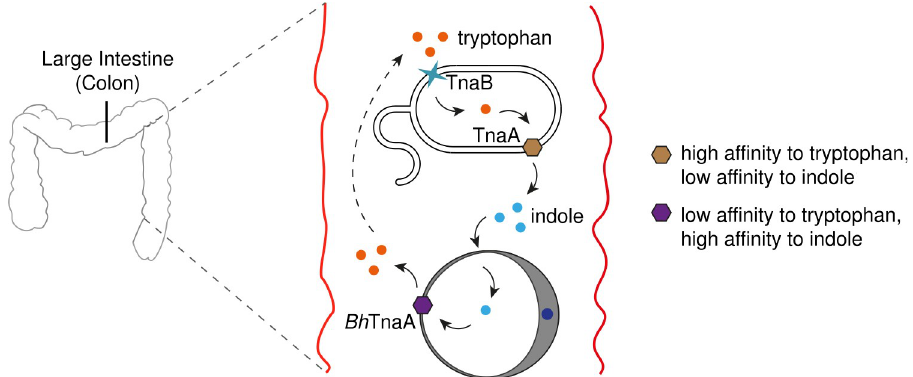
Fig 9. Tryptophan and Indole may exist cyclically in a Blastocystis -infected gut. Diagram of a hypothetical ‘tryptophan cycle’ between E . coli (upper) and Blastocystis spp . (lower) within the descending colon. Tryptophan is shown in orange, and indole is shown in blue. TnaA enzymes are depicted as hexagons, and E . coli tryptophan permease (TnaB) is depicted as a blue star. Extracellular tryptophan is taken up by E . coli using TnaB [43], and was processed into indole by TnaA before being secreted back into the environment. Blastocystis takes up and converts the indole back into tryptophan using Bh TnaA, before secreting it. This tryptophan can then be re-metabolised by E . coli